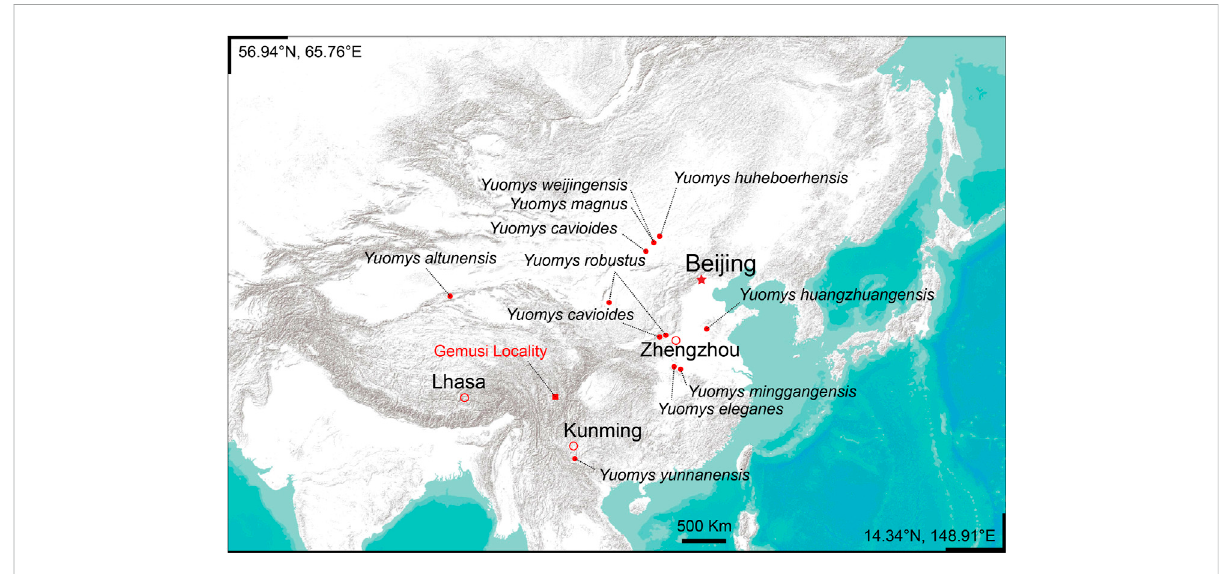
FIGURE 1 Locality of the Gemusi pull-apart basin and the distribution of Yuomys